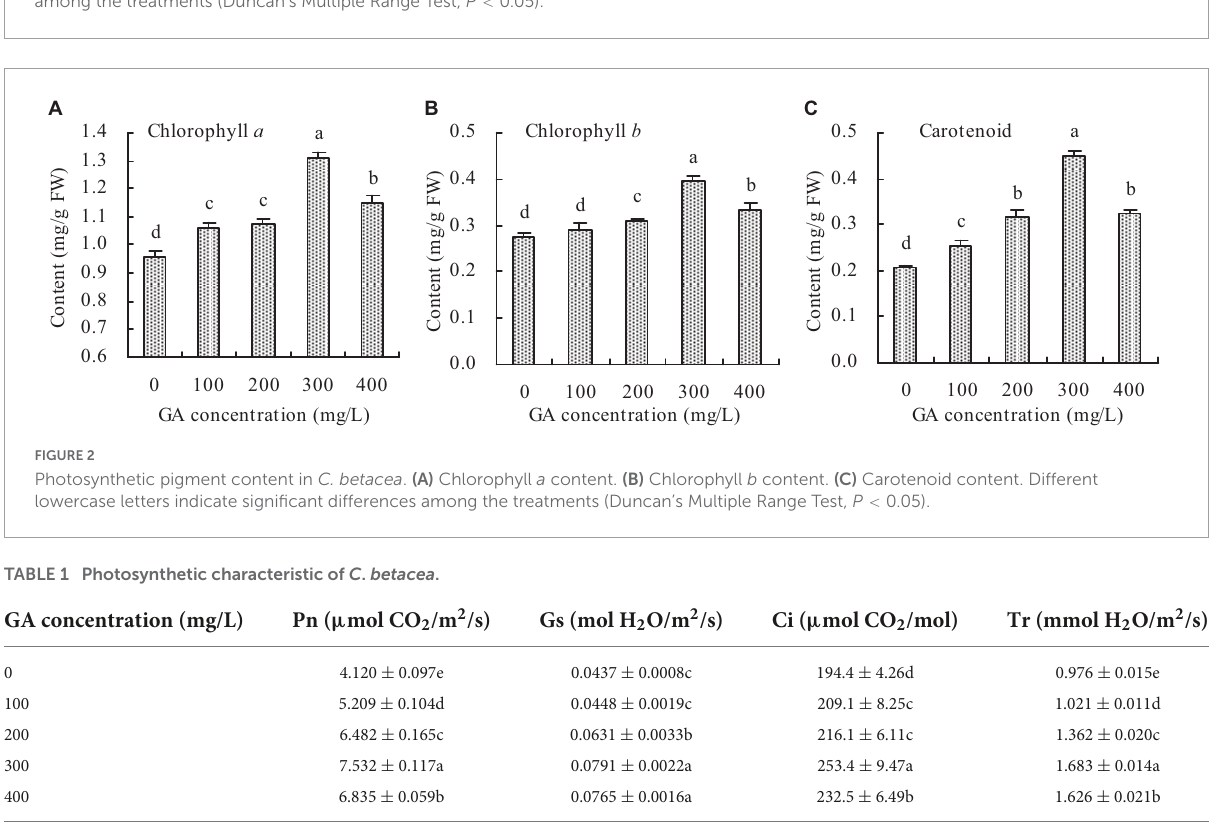
Values are means ( ± SD) of three replicates. Different letters indicate significant differences among the treatments (Duncan’s Multiple Range Test, p < 0.05). Pn, net photosynthetic rate; Gs,stomatalconductance;Ci,intercellularCO 2